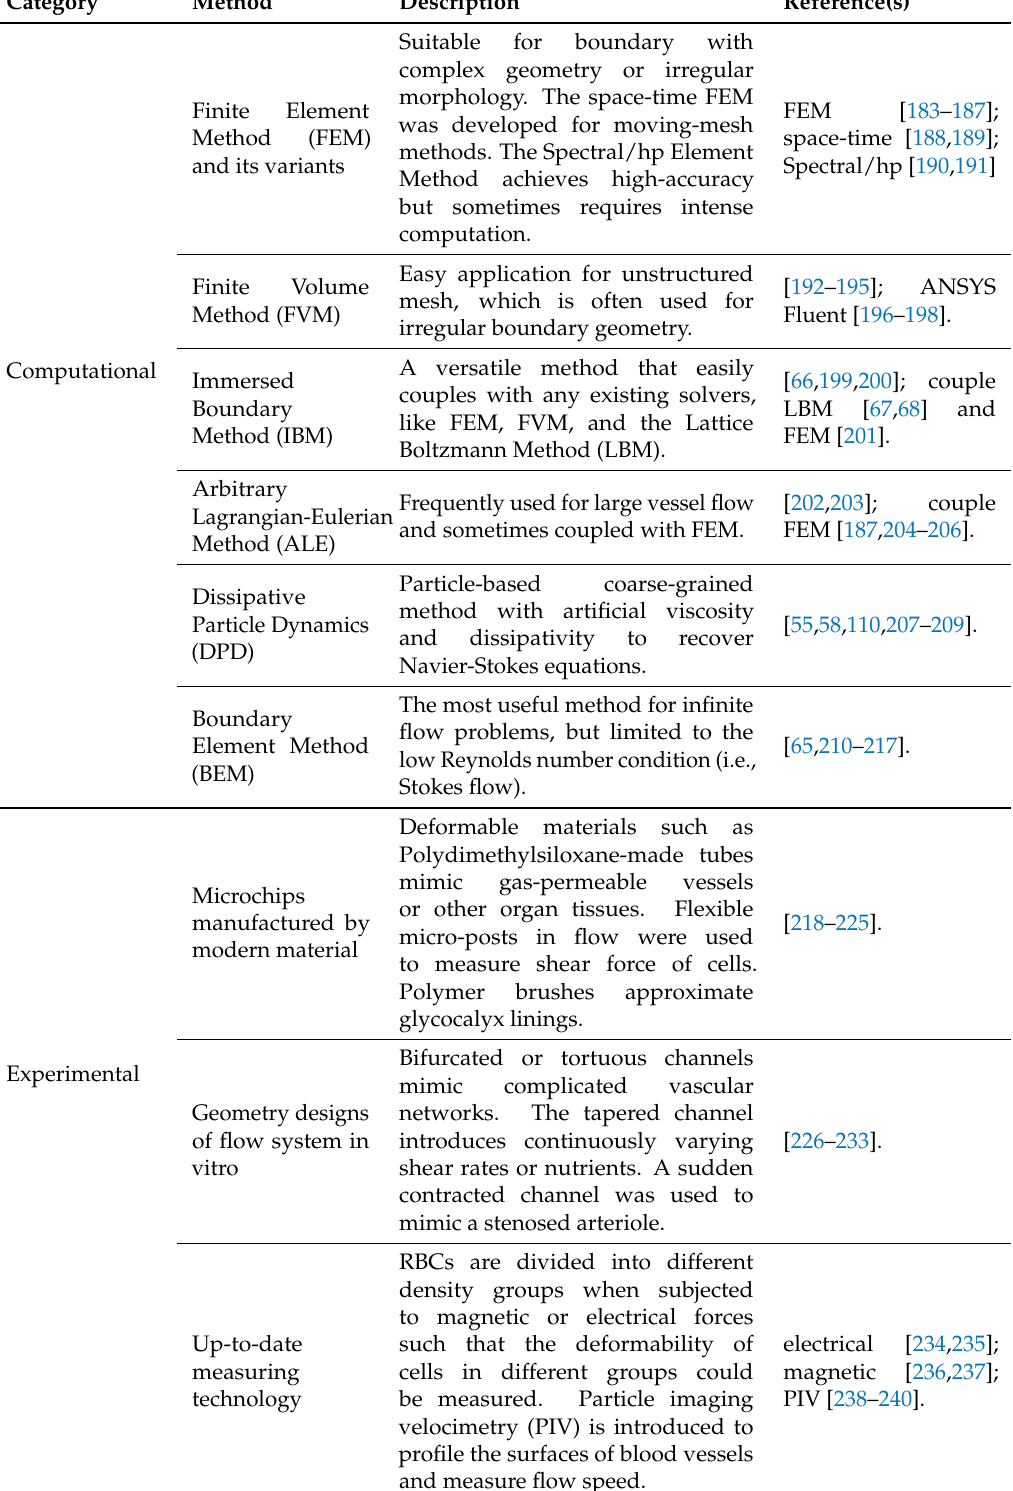
Table 1. Summary of recent computational and experimental methods for studying blood